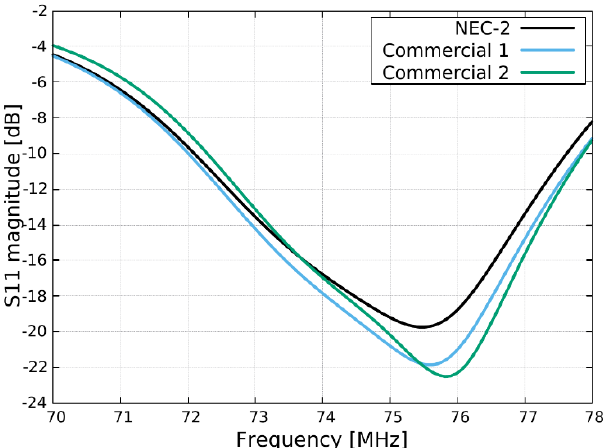
Fig. 6. Reflection coefficients of the analysed 3-element Yagi. Black line: nec2c; Blue line: commercial code 1; Green line: commercial code 2.